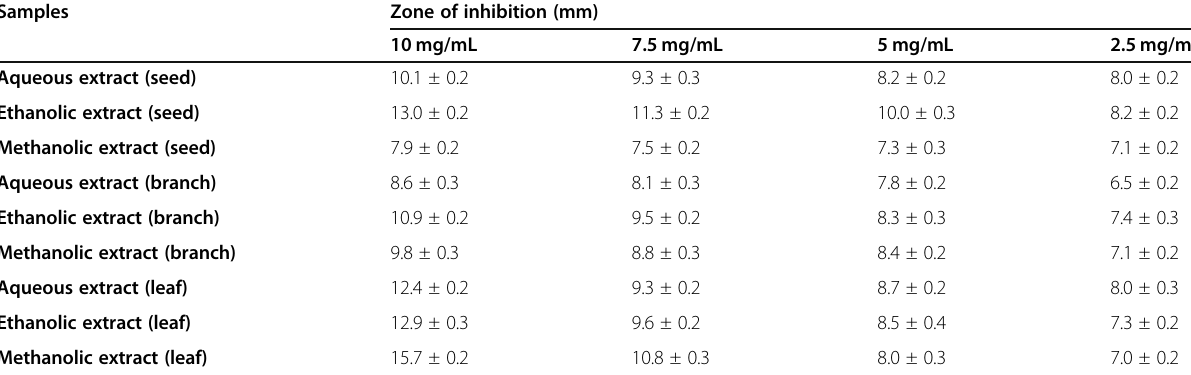
Table 3 Zone of inhibition observed for Gram-positive bacteria Bacillus subtilis by different concentrations of extracts